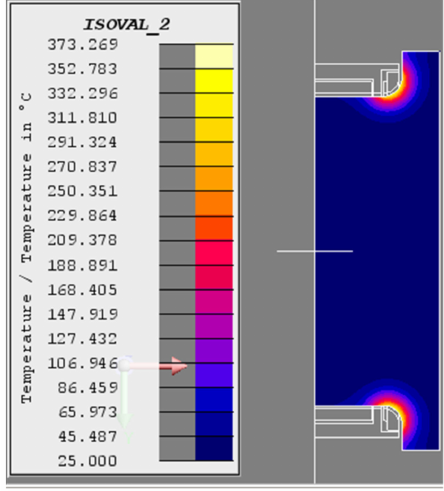
Figure 4. Temperature field of the crankshaft (T = 3 s).